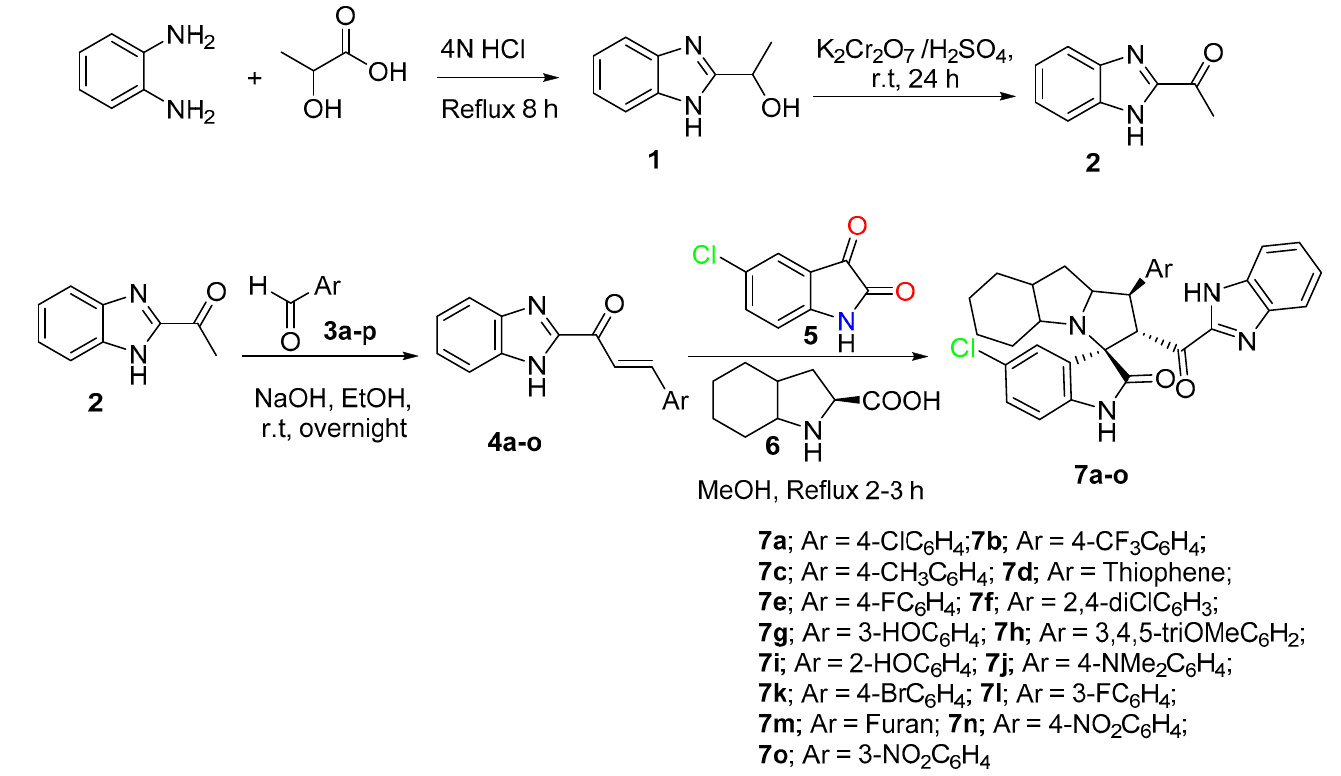
Scheme 1. Synthetic methodology for the desired spirooxindole derivative 7a-o